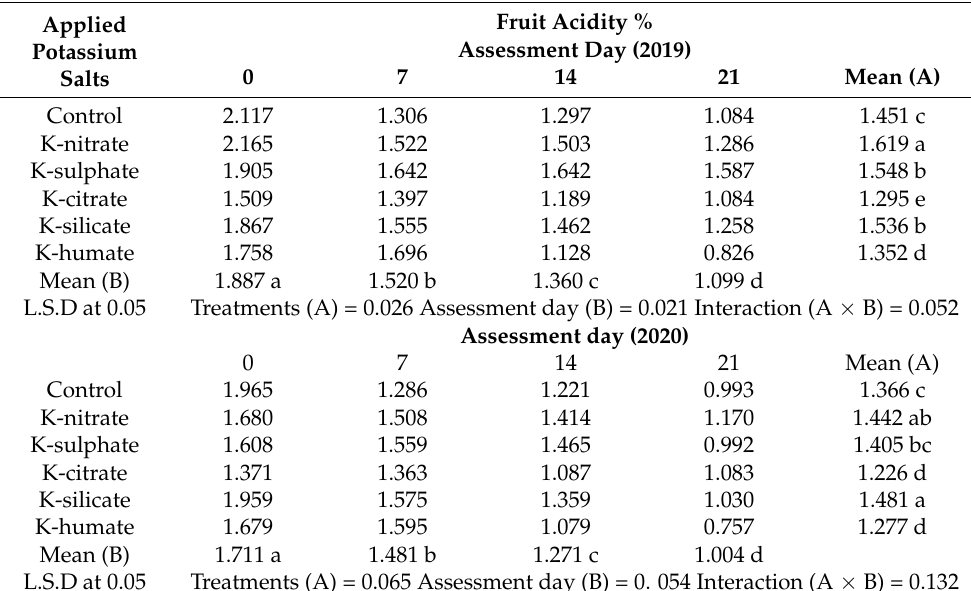
Table 7. Effect of diverse potassium forms as foliar application on acidity % of apricot fruits